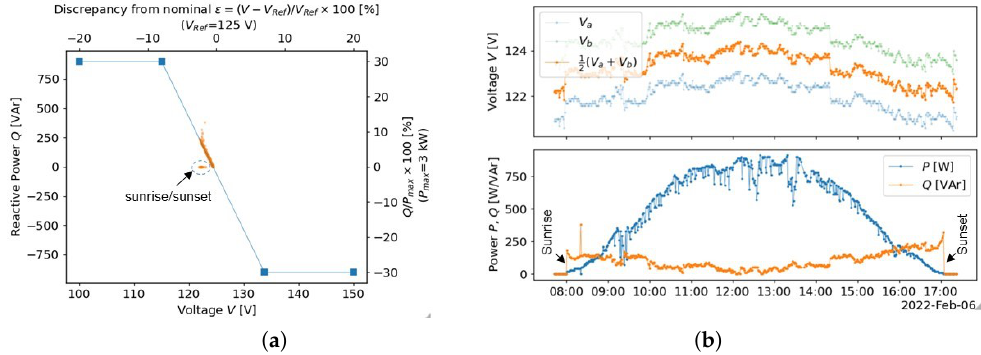
Figure 19. Full-day static curve operation: ( a ) scatter plot on the curvel ( b ) time-domain